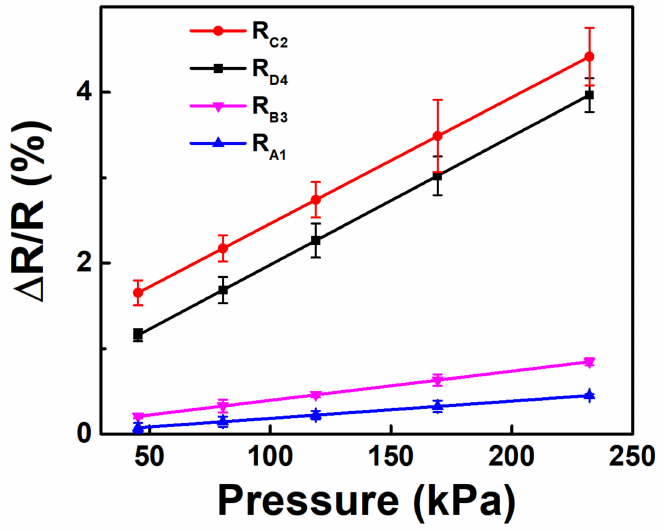
Figure 4. The relative resistance changes between the 4 pairs of electrodes at the location of (5.1 cm, 3.9 cm) under di ff erent